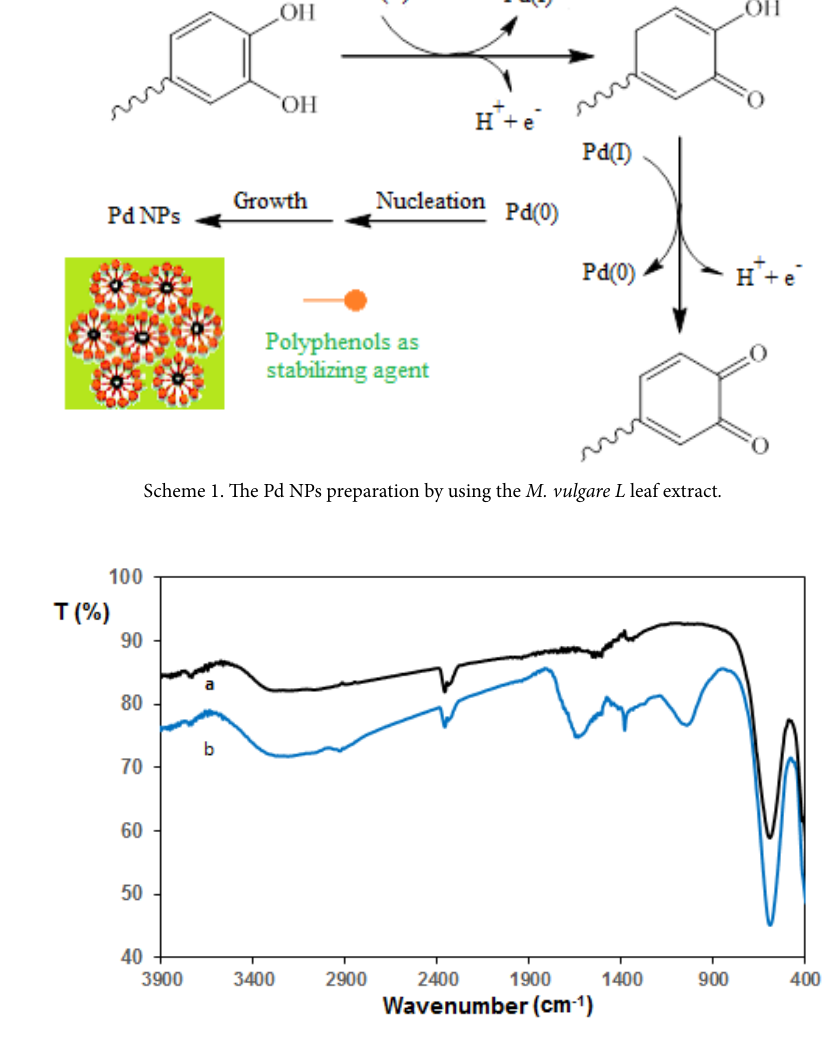
O (a) and Pd/NiFe 2 4